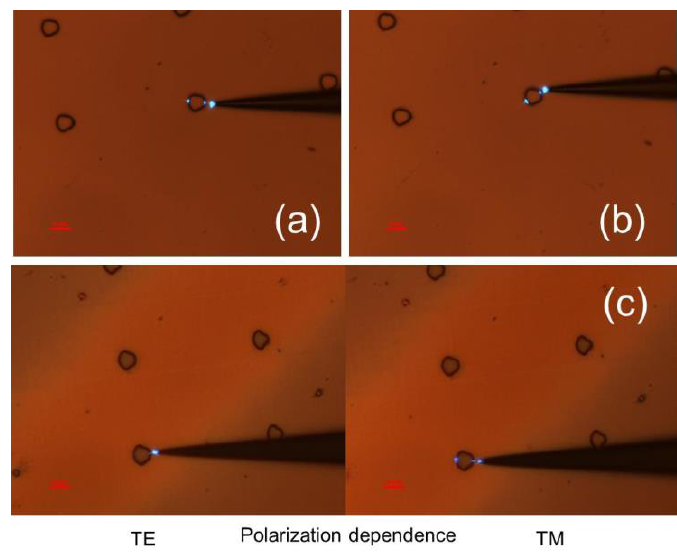
Figure 2. Experimental testing of angular ( a , b ) and polarization ( c ) performance of the magnifying fisheye lenses at λ = 488 nm. The scale bar length is 5 μm in all images.